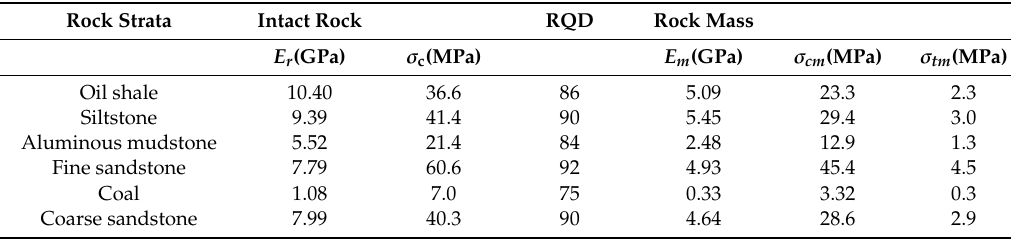
Table 1. Properties of intact rock and rock mass in the Yaojie No.3 Coal Mine. Rock